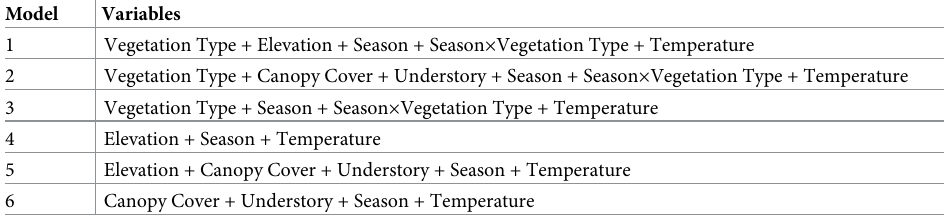
Table 1. Candidate models for single-species occurrence based on a priori